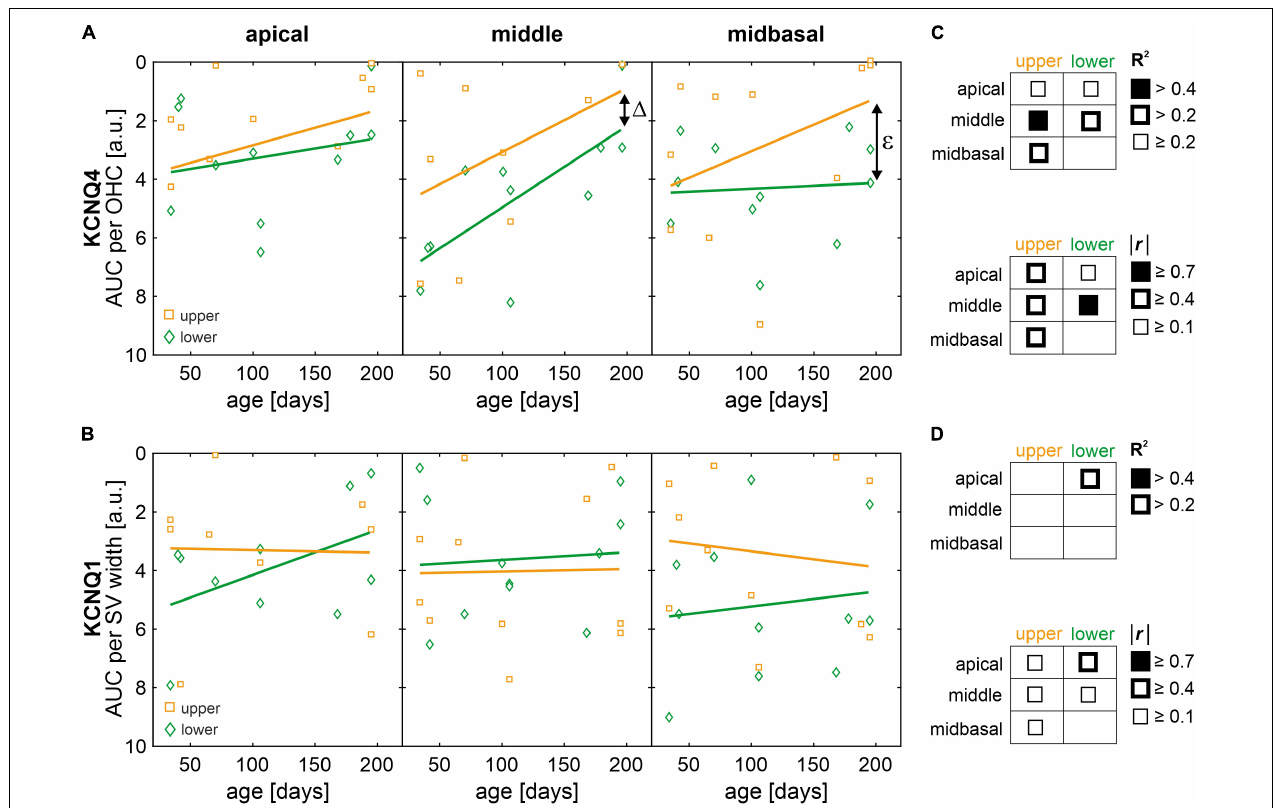
FIGURE 9 | Scatterplots of normalized areas under the curve (AUC) of KCNQ4 and KCNQ1 immunofluorescence as a function of age with regression and correlation analysis. (A) AUC of KCNQ4 immunofluorescence per outer hair cell (OHC) over age for mice in the lower (green diamonds) and upper (orange squares) quartiles, for the apical, middle, and midbasal turns, respectively. Fitted linear regression models (solid lines) are shown for mice in the lower (green) and upper (orange) quartiles, respectively. (cid:49) indicates the difference of intercepts between models for mice in the lower and upper quartiles and ε indicates the increase in difference over age between the lower and upper quartiles. (B) AUC of KCNQ1 immunofluorescence per stria vascularis (SV) width over age for mice in the lower (green diamonds) and upper (orange squares) quartiles, for the apical, middle, and midbasal turns, respectively. Fitted linear regression models (solid lines) are shown for mice in the lower (green) and upper (orange) quartiles, respectively. (C,D) Graphical representations of the coefficient of determination ( R 2 , upper tables) ranges of the linear regression models and the modulus correlation coefficients (Pearson’s r , lower tables) for KCNQ4 (C) and KCNQ1 (D) . Note that none of the correlation coefficients was significantly different from